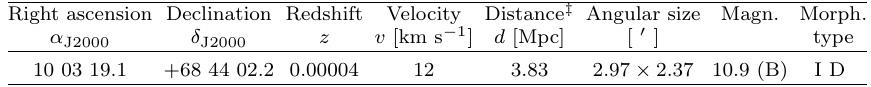
Table 1. Data for NGC 3077 taken from SIMBAD †